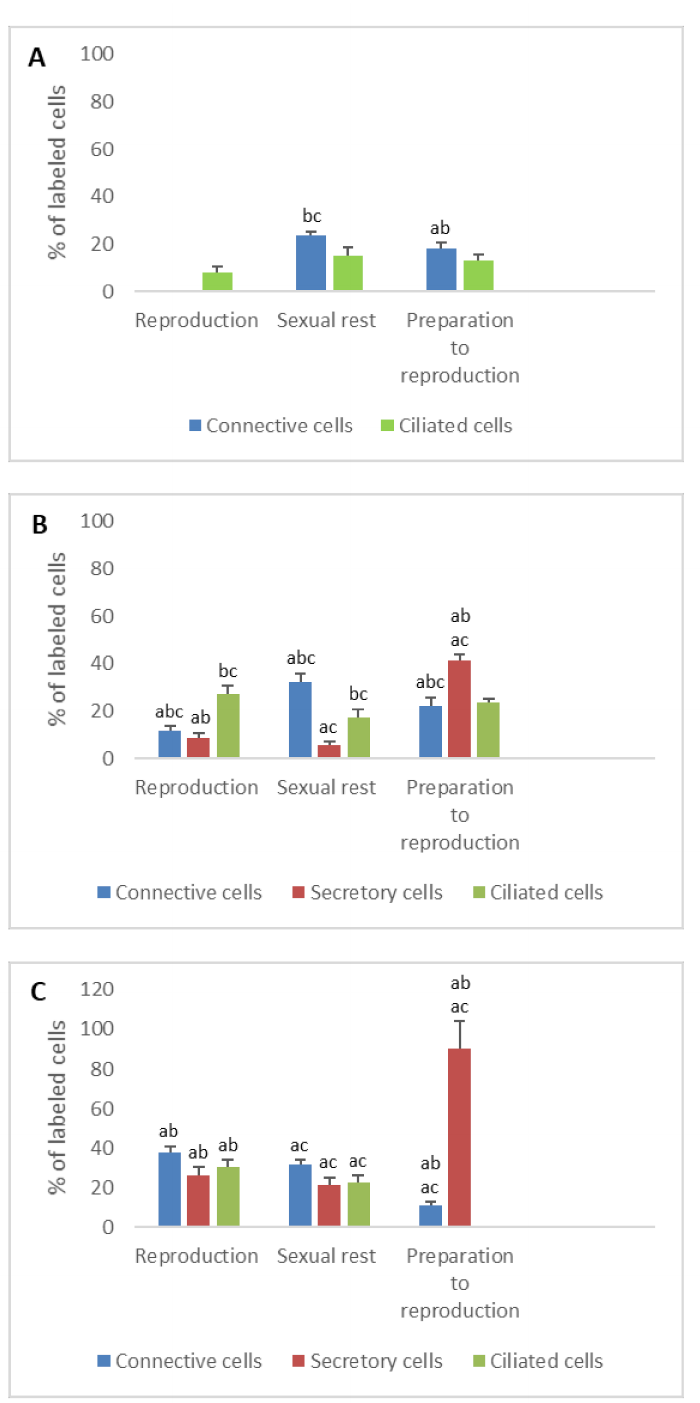
Figure 7. Percentage of PRLR immunodetected in the different cell types of the genital tract of Typhlonectes compressicauda before ovulation and during the reproduction period (pregnant females) and sexual rest (quiescent females). Significant differences (ANOVA, α = 0.05) between the 3 groups of females (a: before ovulation; b: pregnant females; c: quiescent females) are reported with the letters a, b, c. ( A ) Ostium (connective cells n = 6, Pr > F: 0.002, ciliated cells n = 6, Pr > F: 0.158); ( B ) Tubal part (connective cells n = 6, Pr > F: 0.013, secretory cells n = 6, Pr > F: 0.000, ciliated cells n = 6, Pr > F: 0.095); ( C ) Uterus (connective cells n = 6, Pr > F: 0.004, secretory cells n = 6, Pr > F: 0.007, ciliated cells n = 6, Pr > F: